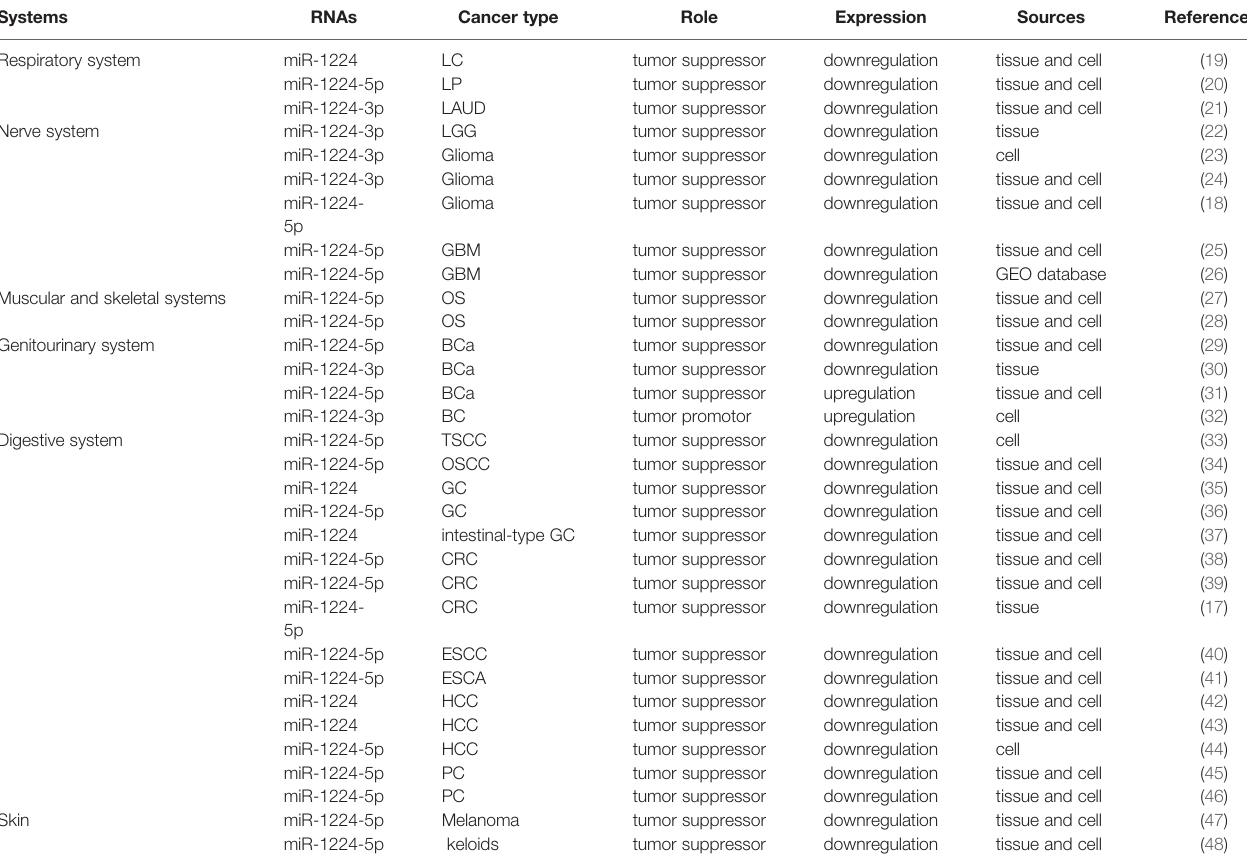
TABLE 1 | Expression pro fi les of miR-1224 in human